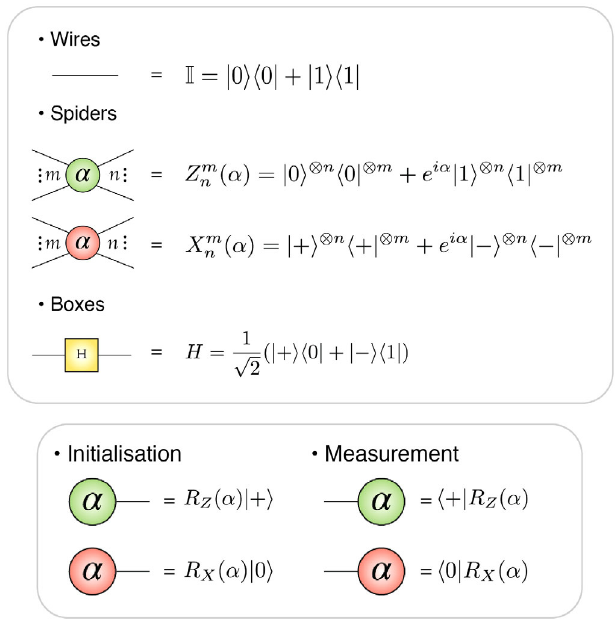
FIG. 3. ZX-calculus elements and their associated linear operations. Initialization and measurement operations in the Z and X